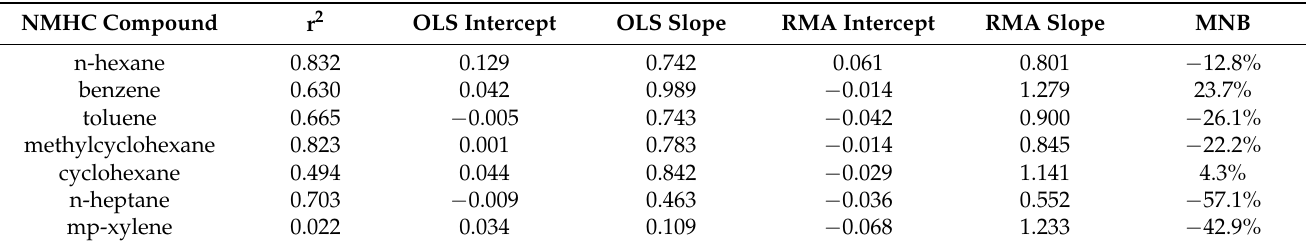
Table 1. Regression statistics for selected NMHCs comparing averaged hourly state monitor mea- surements to passively sampled data for 5–17-day deployment periods. OLS = ordinary least squares, RMA = ranged major axis, MNB = mean normalized bias [76].